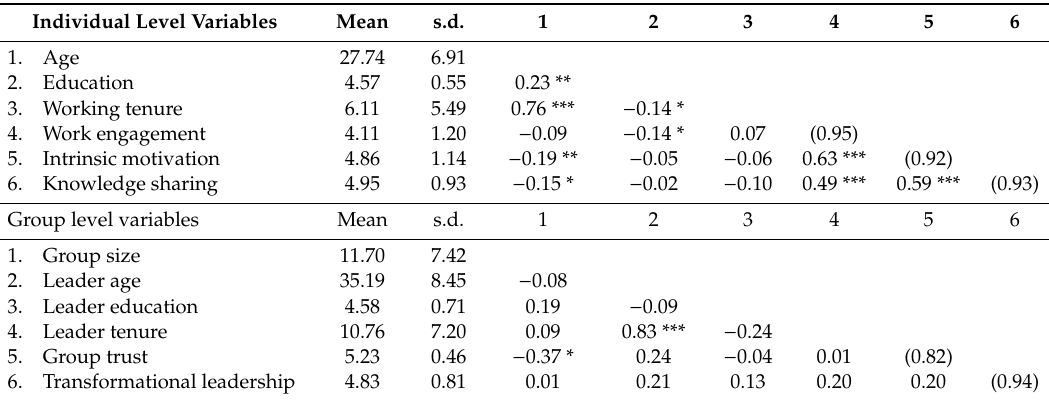
Table 1. Means, standard deviations, and